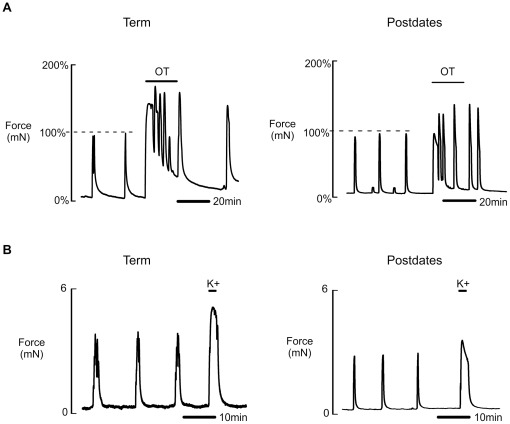
The response to oxytocin and high K+ in term and postdates myometrium.After establishing stable spontaneous myometrial contractions, 10 nM oxytocin (OT) (A) or high K+ (B) was added for 20 min and 2 min respectively. Response to OT was compared between term and postdates myometrium by measuring both the force amplitude and the percentage increase in force amplitude of contraction under OT where control activity equalled 100% (as shown in A). The response to high K+ (mean force amplitude of contraction) was compared between groups and was found to be significantly reduced in postdates myometrium compared to term.